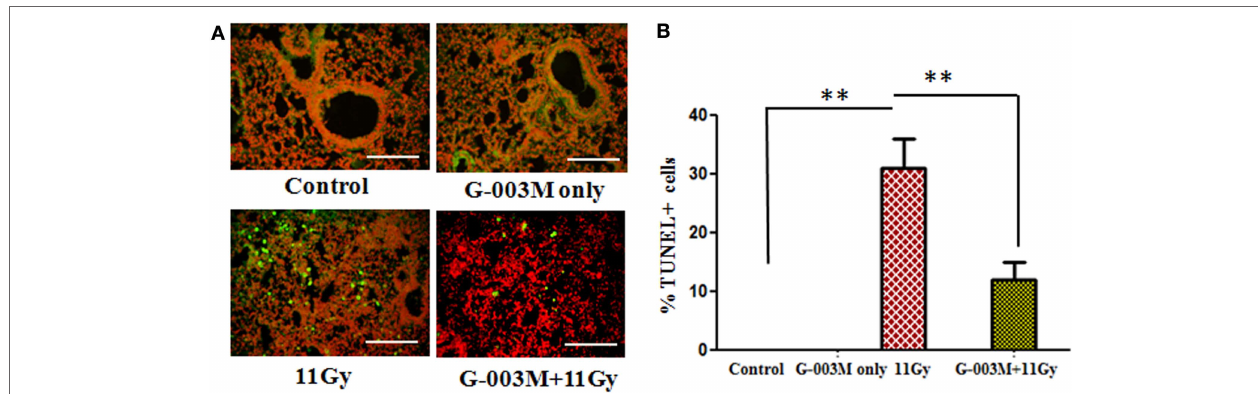
FigUre 4 | G-003M protects pulmonary cells from radiation-induced cell death in 11 Gy thoracic-irradiated mice. DNA fragmentation was performed in lung sections using in situ terminal deoxynucleotidyl transferase dUTP nick-end labeling (TUNEL) method. (a) Representative micrographs of TUNEL (green) and PI (red) double staining in differentially treated mice at 1 week postradiation. (B) Bar graph showing the average number of TUNEL + cells in lungs. Images were viewed at 200 × under fluorescence microscope. Scale bar 100 µm. Data are represented as means ± SEM from six mice for each group. ** p < 0.001.